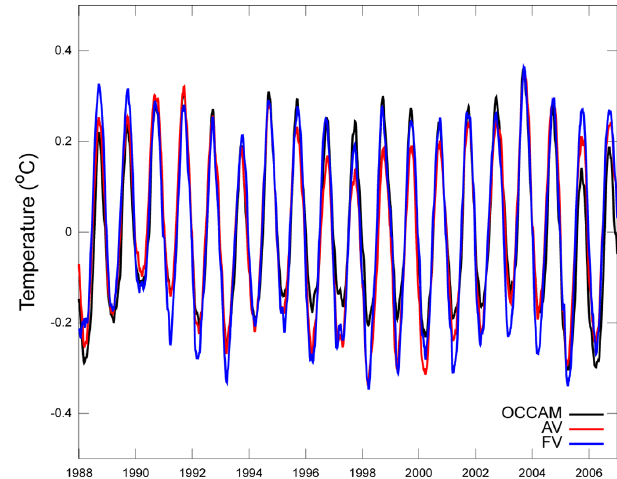
Fig. 4. Demonstration of box model performance, OHC detrended and with the mean removed. The black line is from the full OCCAM model, red line from the AV box model and the blue line from the FV box model run with data taken from OCCAM for F ∗ , using 26 ◦ N this to infer the F ∗ , but otherwise as described in Sect. 2.3. Both 36 ◦ N box model versions show good agreement with the OCCAM model, with StD of difference from the OCCAM model of 0.057 ◦ C for the AV box model and 0.065 ◦ C for the FV box model, compared to the StD of the full OCCAM model with an StD of 0.16 ◦